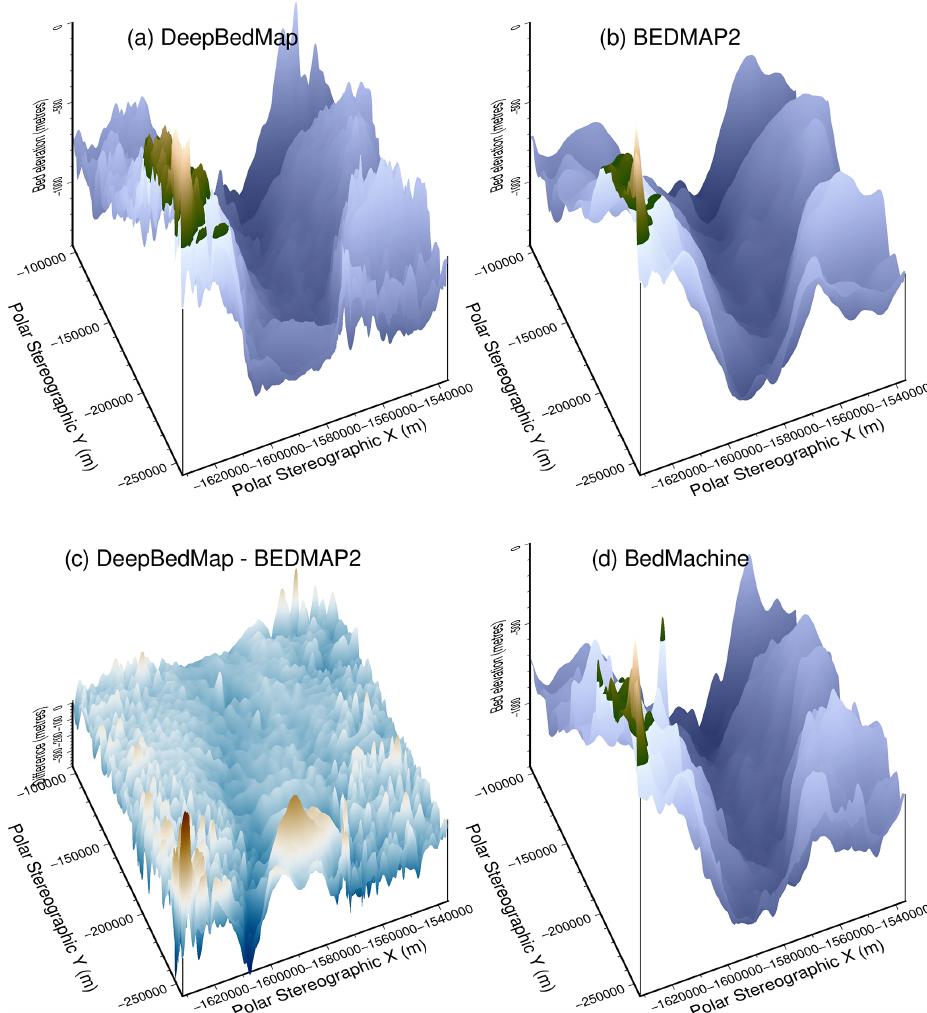
Figure 3. Comparison of interpolated bed elevation grid products over Pine Island Glacier (see extent in Fig. 2). (a) DeepBedMap (ours) at 250m resolution. (b) BEDMAP2 (Fretwell et al., 2013), originally 1000m, bicubically interpolated to 250m. (c) Elevation difference between DeepBedMap and BEDMAP2. (d) BedMachine Antarctica (Morlighem, 2019), originally 500m, bicubically interpolated to